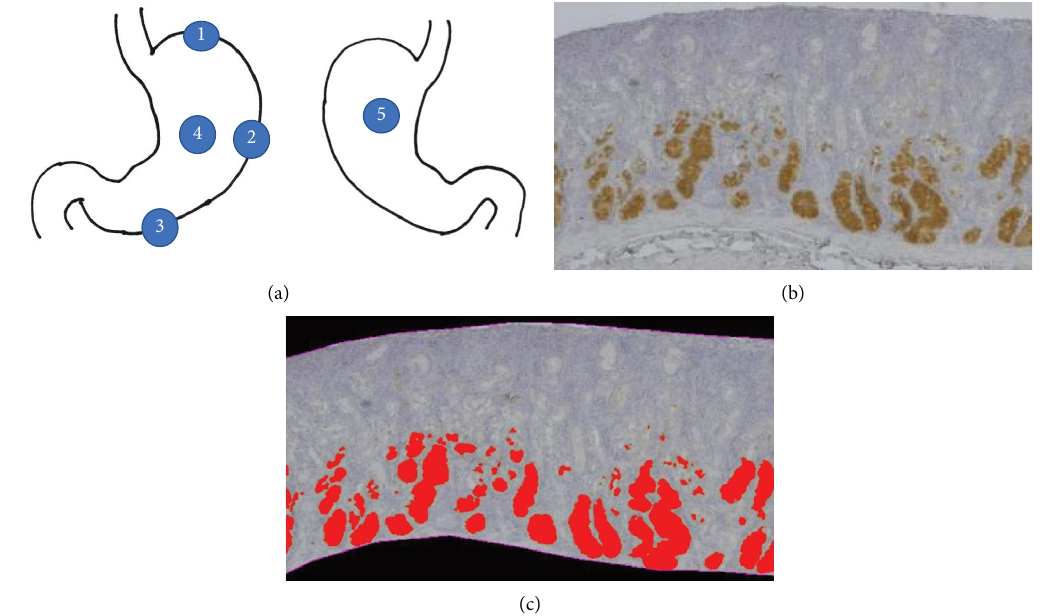
Figure 1: Quantifcation of TRPV4 expression. (a) Sites where tissue samples were taken and the quantifcation method for stained areas. Tissue was collected from 57 patients who underwent gastric resection. Te following areas were sectioned in all layers: 1. greater curvature of the fornix; 2. greater curvature of the gastric body; 3. greater curvature of the antrum; 4. anterior wall of the gastric body; 5, posterior wall of the gastric body. (b) TRPV4 immunostaining in gastric tissue. (c) Te images were captured using a microscope with BZ-X710 (Keyence, Osaka, Japan), and staining was quantifed with hybrid cell count